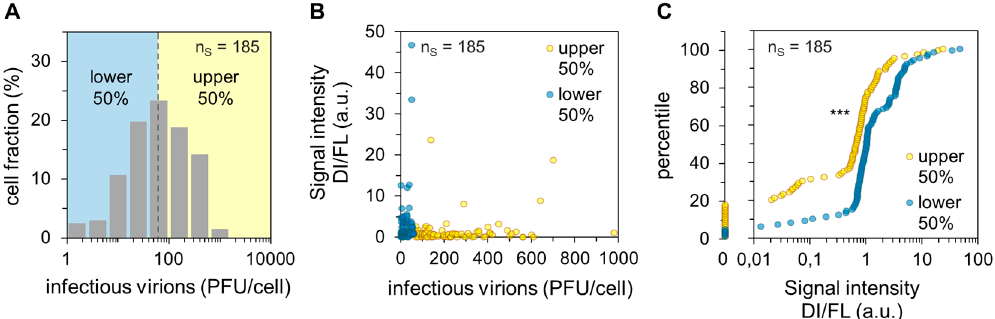
Figure 2. Dependency of the single-cell virus yield on intracellular DI vRNAs. Single PR8-infected MDCK cells (MOI = 10) were investigated for the presence of DI vRNAs on S1–S3 by single-cell RT-PCR and released virus yields by plaque assay at 12 hpi (as shown Figure 1). The pooled data of six independent experiments are shown. n S indicates the number of single-cell measurements. ( A ) Histogram of the single-cell virus yield. Dashed line indicates the median of virus titer (60 plaque-forming units (PFU)). ( B ) Dependency of the virus yield on the quantity ratio of DI to FL vRNAs. The signal intensities of the DI and FL vRNAs from agarose gels were quantified using ImageJ. Afterward, the quantity ratios were calculated by dividing the sum of signal intensities of the DI vRNAs on S1–S3 by the sum of the signal intensities of the FL vRNAs on S1–S3. ( C ) Percentile graph of the data shown in (B). The data were divided into 100 quantiles. ***, p < 0.0005 by the Wilcoxon rank sum test.